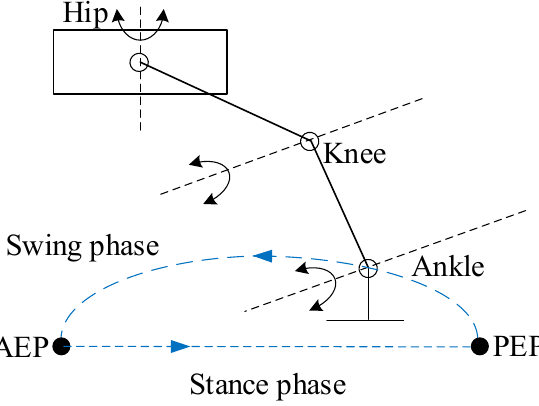
Figure 4. The foot trajectory planning of the hexapod robot.